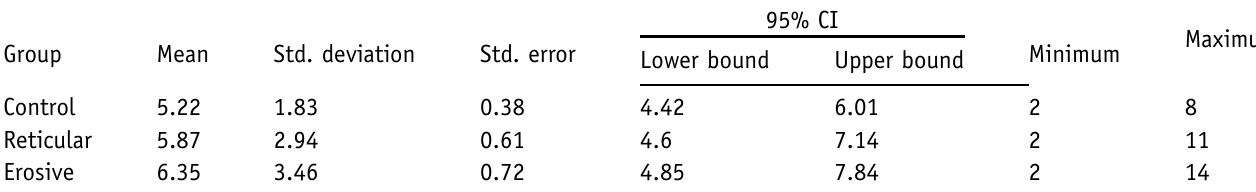
Table III. Measures of central dispersion for the anxiety score in the three groups ( n = 23). Group Mean Std. deviation Std. error